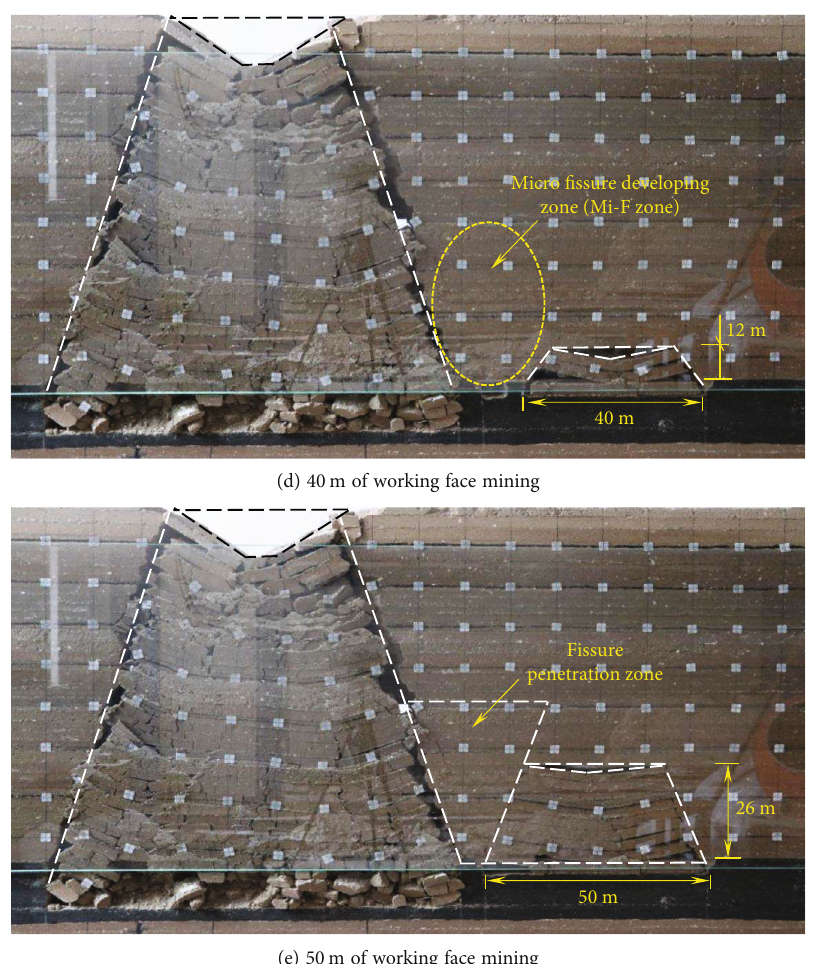
Figure 10: Evolution of overburden structure in a fi rst-layer working face in section